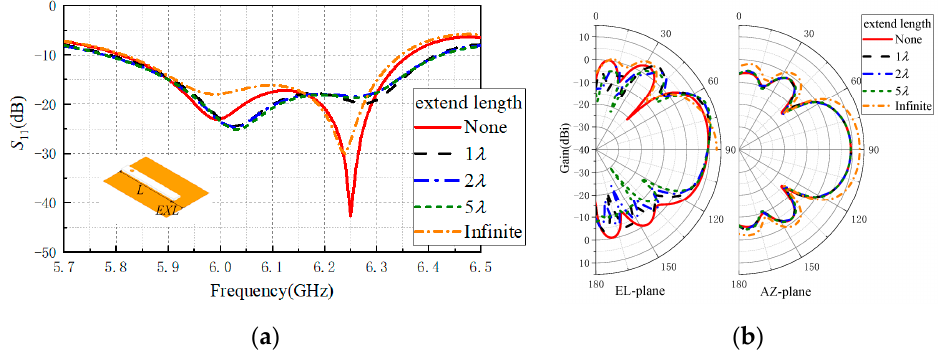
Figure 5. Performance of the proposed antenna with di ff erent lengths of an extended ground plane in + y direction: ( a ) reflection coe ffi cients, ( b ) radiation